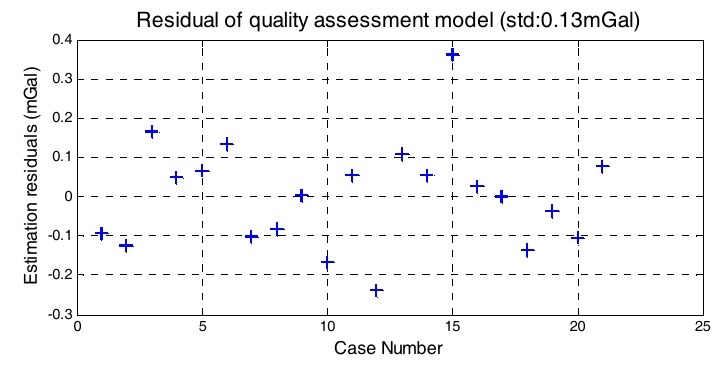
Figure 10. Residuals of new model.